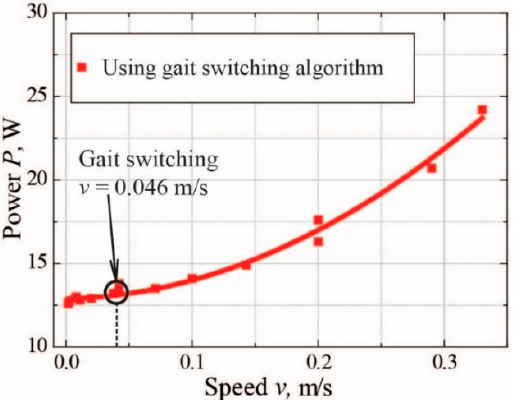
Figure 7. Influence of gait switching on energy consumption. Speed for switching from wave gait to tripod gait is equal to 0.046 m/s.